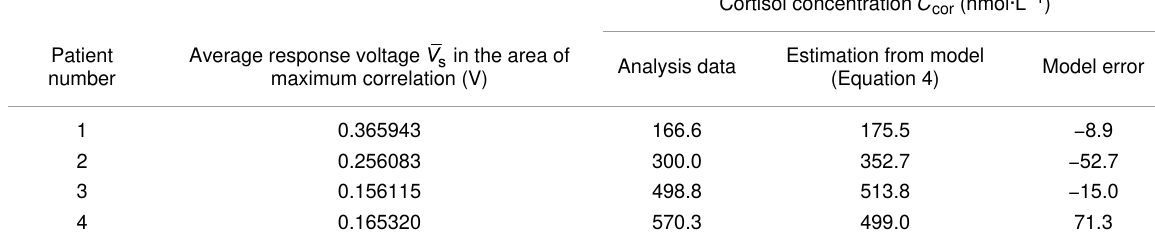
Table 2: Verification of the sensor model for the determination of cortisol